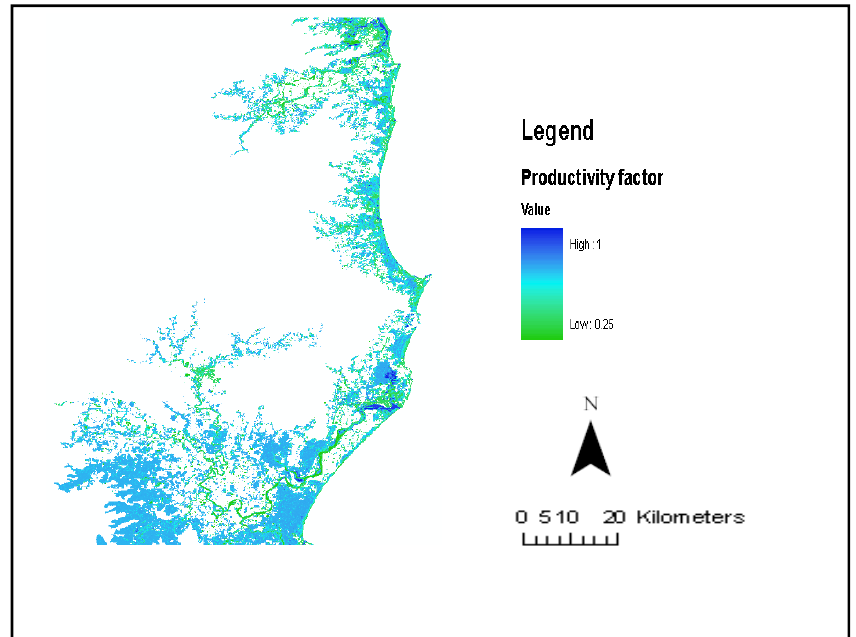
Figure 8. Productivity factor of methane emission for the wetland